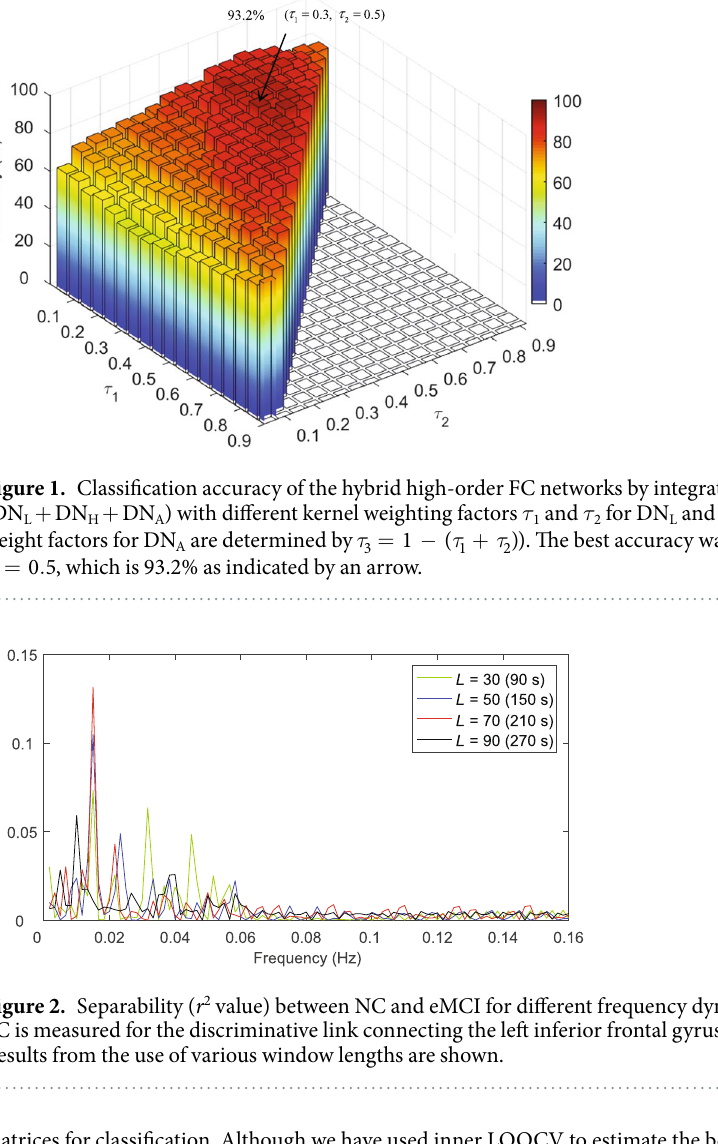
shows accuracy of the classification model based on DN L + DN H + DN A estimated using LOOCV on all of the N subjects, with different combinations of the three weighting factors τ 1 , τ 2 and τ 3 (where is τ τ τ = − + 1 ( ) ). 3 1 2 After the exhaustive searching, the best accuracy of 93.2% is achieved with τ = . 0 3 (for DN L ), τ = . 0 5 (for DN H ), 1 2 (for DN A ). The results indicate that DN L , DN H and DN A indeed provide comple- and τ τ τ = − + = . 1 ( ) 0 2 3 1 2 mentary information to each other and all of them are necessary for classification. On the other hand, our method with the parameters estimated by inner LOOCV yielded a 91.5% accuracy, which is close to the best accuracy 93.2% with specific parameters estimated on all subjects.